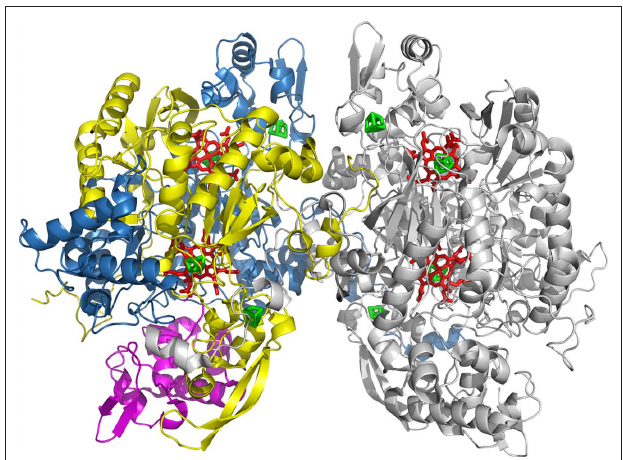
Figure 1 | Cartoon representation of the overall α from D. norvegicum . α (DsrA) is colored in blue, β (DsrB) in yellow, and γ (DsrC) in magenta for one αβγ unit (chains D, E, and F), whereas the other is displayed in gray (chains A, B, and C). Sirohemes and [4Fe–4S] clusters and are represented in sticks and colored respectively red and green.